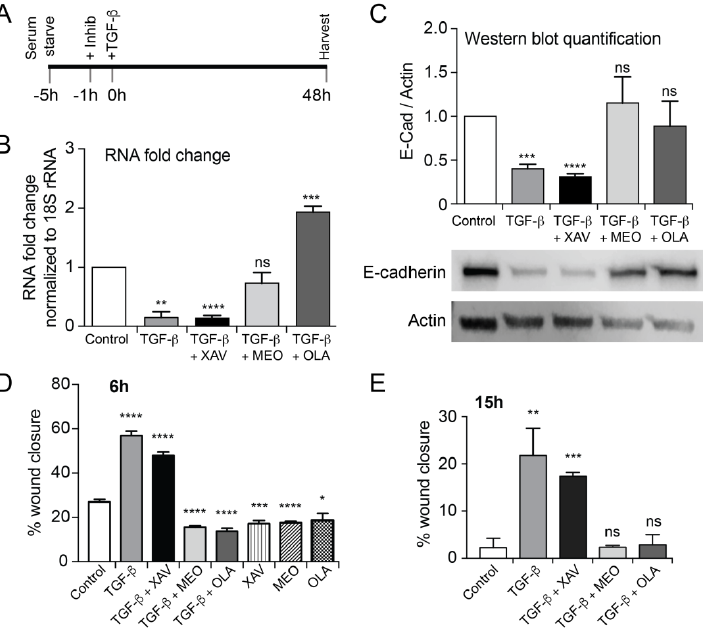
Figure 3. EMT is prevented by PARP-1/2 inhibitor OLA and PARP-3 inhibitor MEO but not by TNKS inhibitor XAV. In addition, 10 µM of each indicated PARP inhibitor was added, according to the experimental schedule ( A ), 1 h before treatment of NMuMG cells with TGF- β (5 ng/mL) for 48 h. E-cadherin mRNA fold increase relative to 18S rRNA ( B ) was evaluated by RT-PCR and E-cadherin protein increase